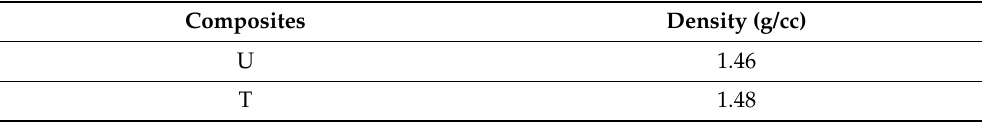
Table 3. Properties of developed